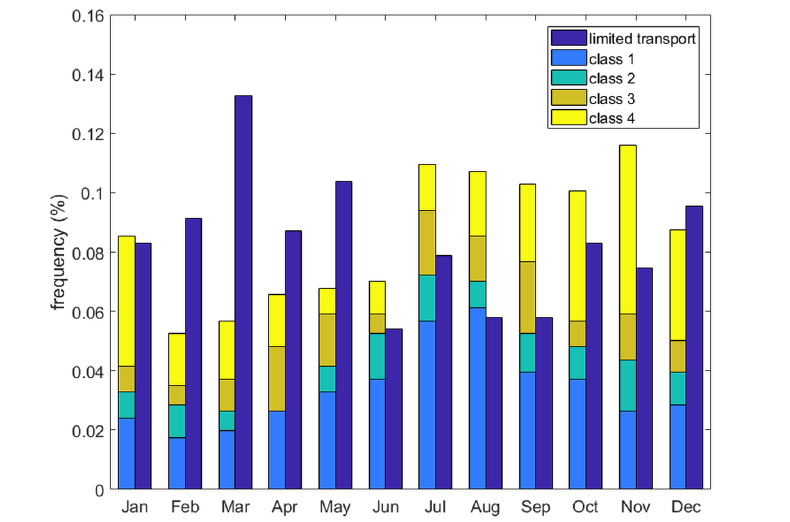
Figure 8. Relative monthly occurrence of limited and unlimited events. The unlimited events shown are separated in the visible transport classes given in Figure 4.